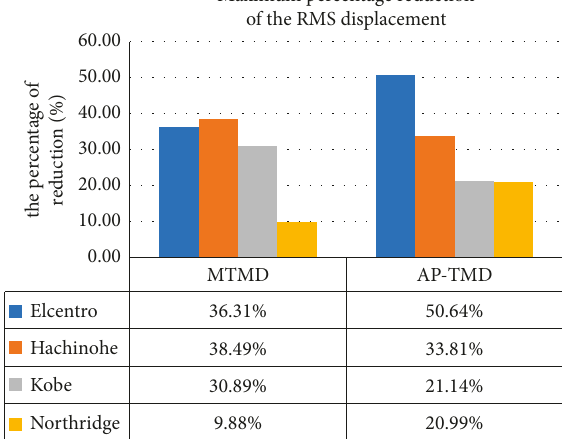
Figure 10: Maximum percentage reduction of the displacement on the roof of the structure with two controllers. Figure 11: Maximum percentage reduction of the RMS dis- placement on the roof of the structure with two